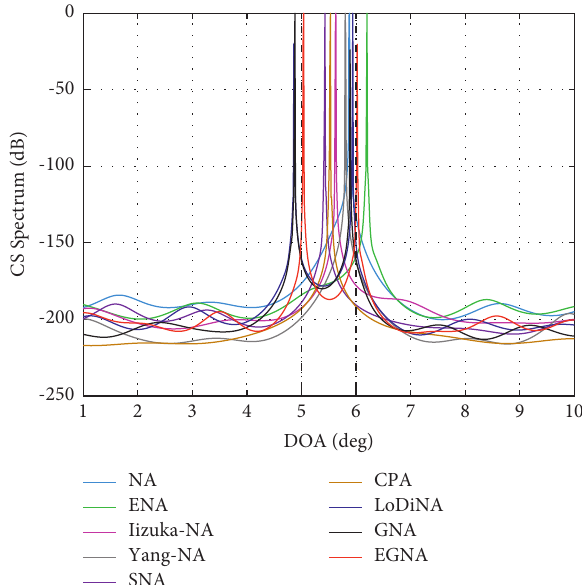
Figure 12: CS spectrum of two nearby targets for different array